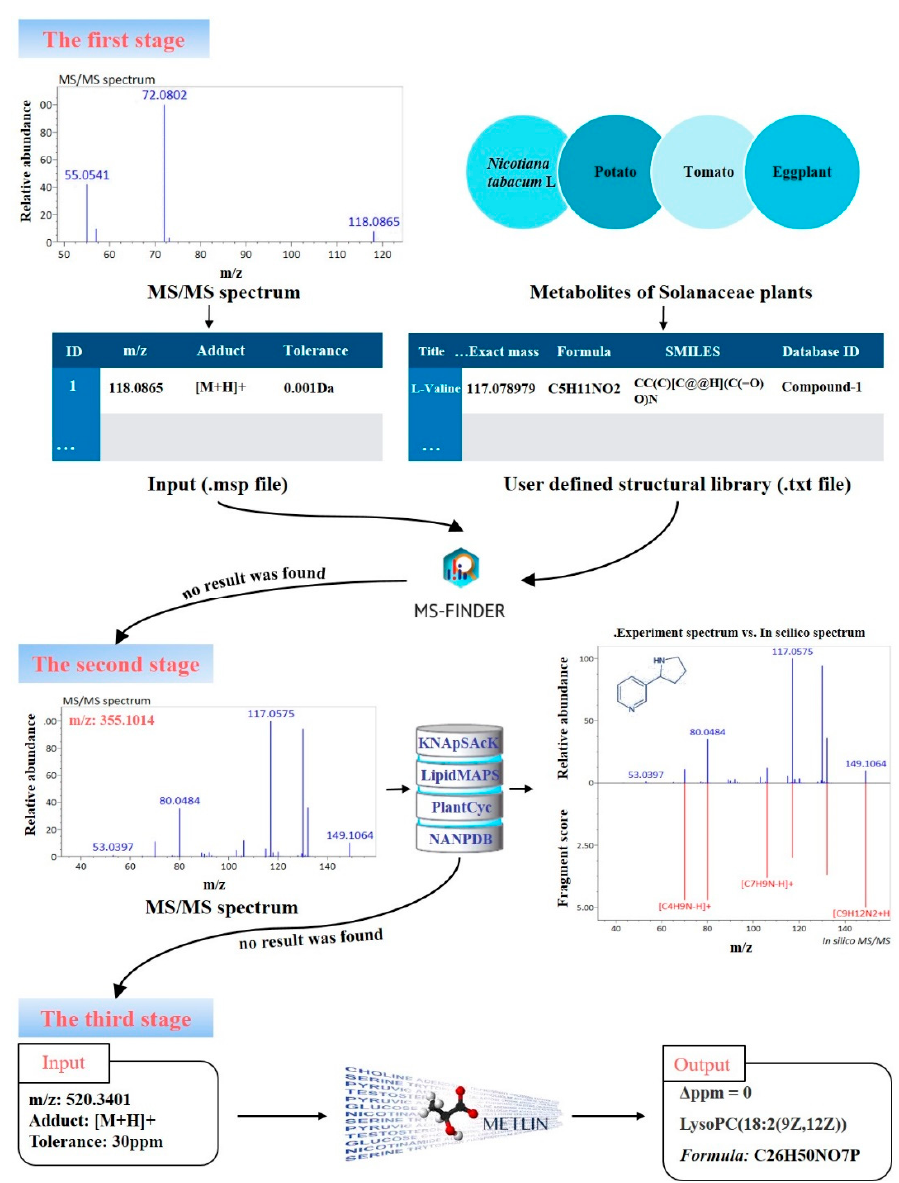
Figure 2. Flow chart of identification of differential metabolites in the flue-cured NTL leaves from three different maturity grades. At the first stage, metabolites were identified by searching the self-built library of Solanaceae plants (NTL, Tomato, Potato, Eggplant). At the second stage, metabolites are identified by searching the metabolomic libraries (KNApSAcK, LipidMAPS, PlantCyc, NANPDB) of plants in MS-FINDER and matching their spectra. At the third stage, metabolites are putatively identified by searching in METLIN, which stored a large number of small molecule metabolites.